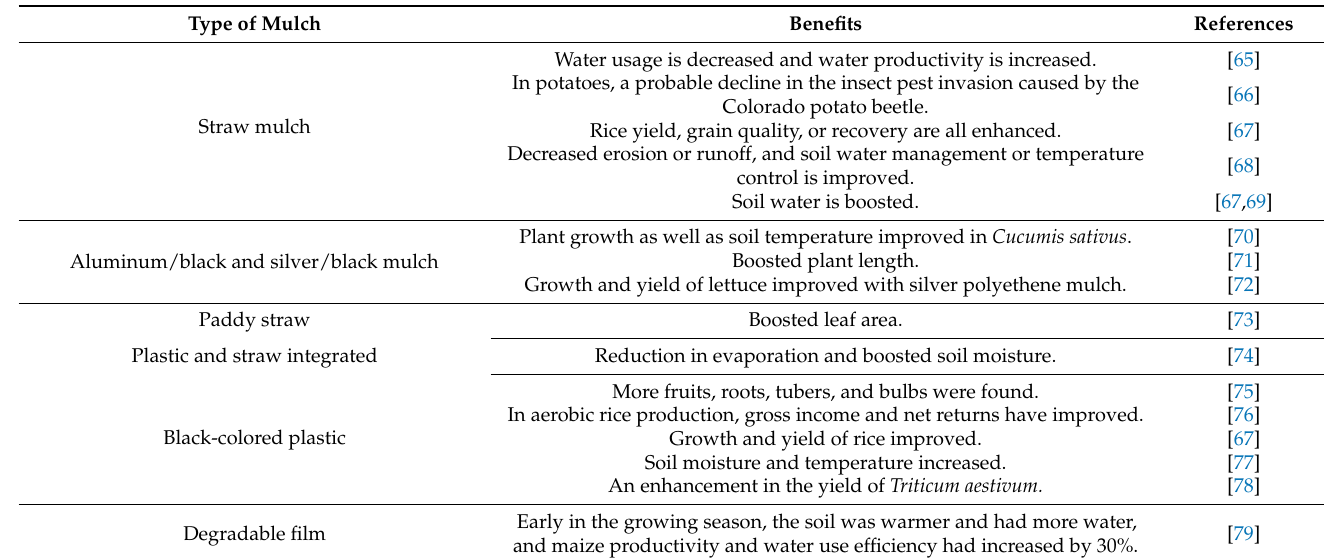
Table 1. Beneficial aspects of various mulch